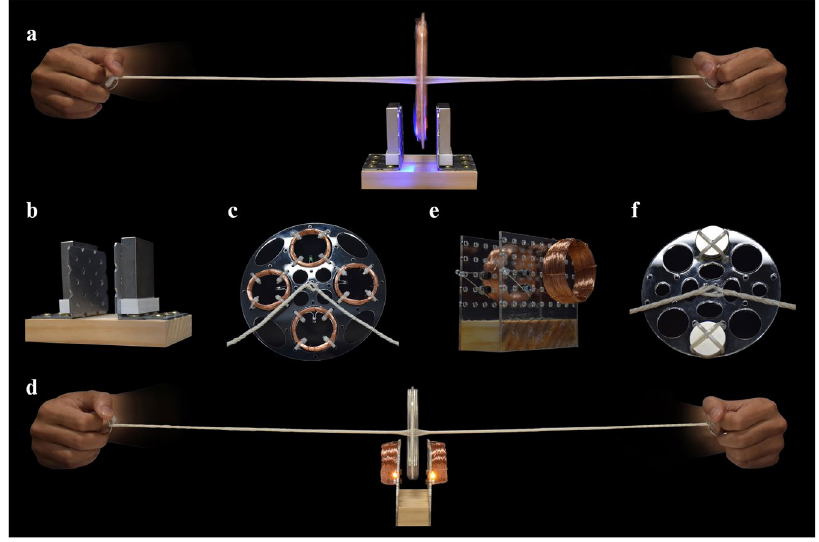
Figure 7. Thread–disk based electric generators. The first generator ( a ) is constructed by the stationary magnets ( b ) and the coils of enameled copper wire ( c ) that are mounted on the spinning disk. The second generator ( d ) is constructed by the stationary coils of wire ( e ) and the lightweight disc magnets ( f ) that are mounted on the perforated disk. All these photographs were taken by the first author Zi-Long